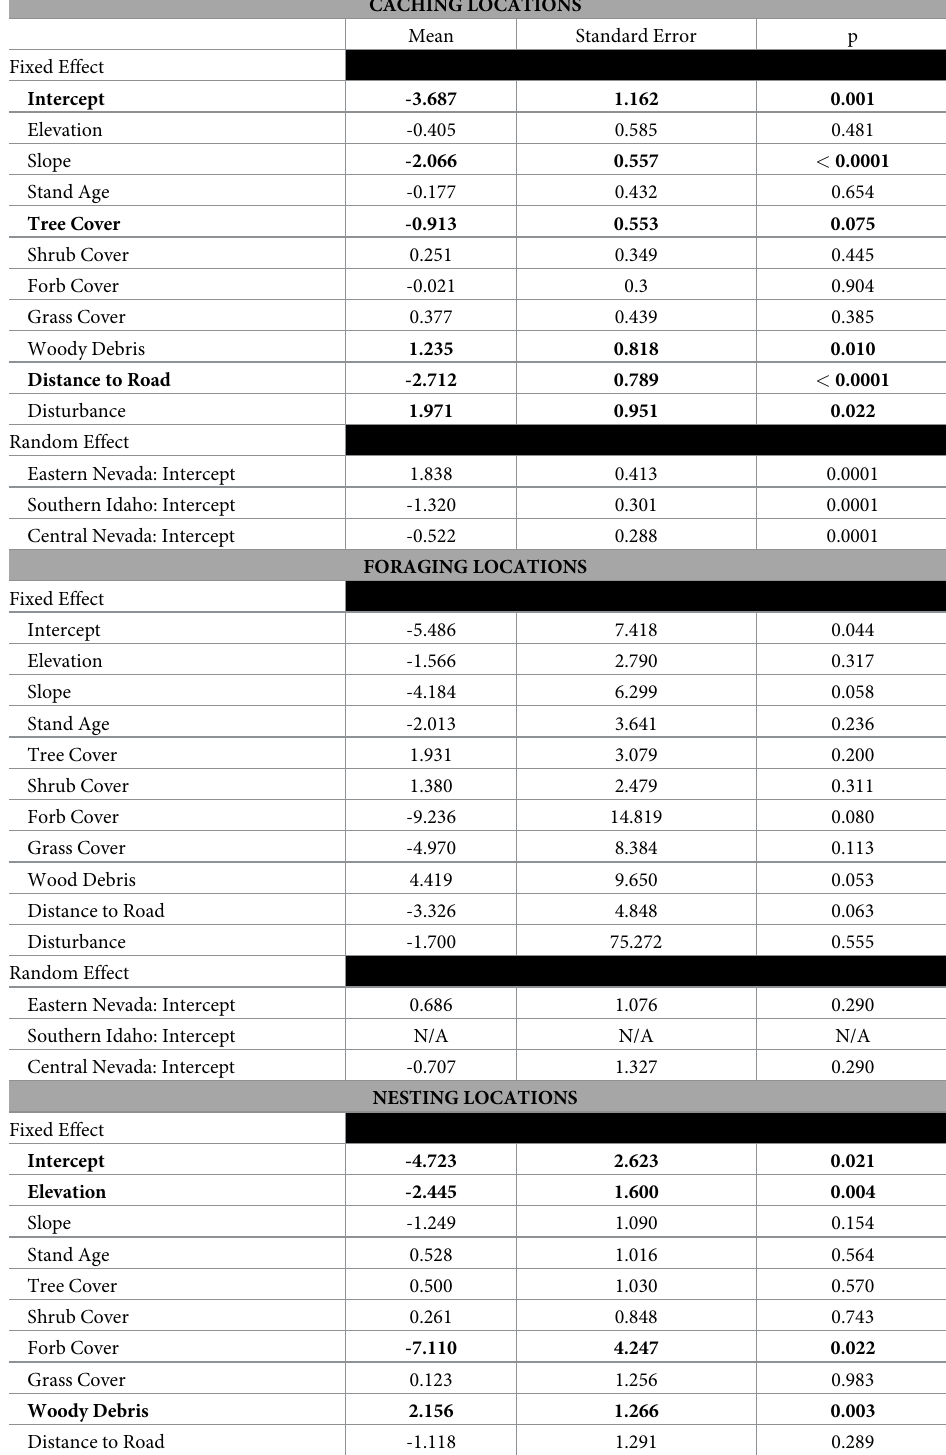
Table 5. Logistic regression